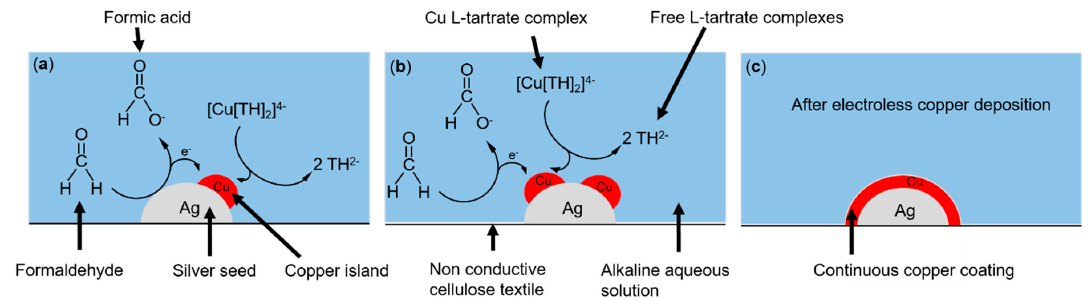
Figure 7. The electroless copper deposition method conducted on cellulose textiles, where the tartrate complex (TH) is a free L-tartrate ligand ( a ). The copper deposition continues on Ag seed ( b ), which leads to the copper layer formation ( c ).